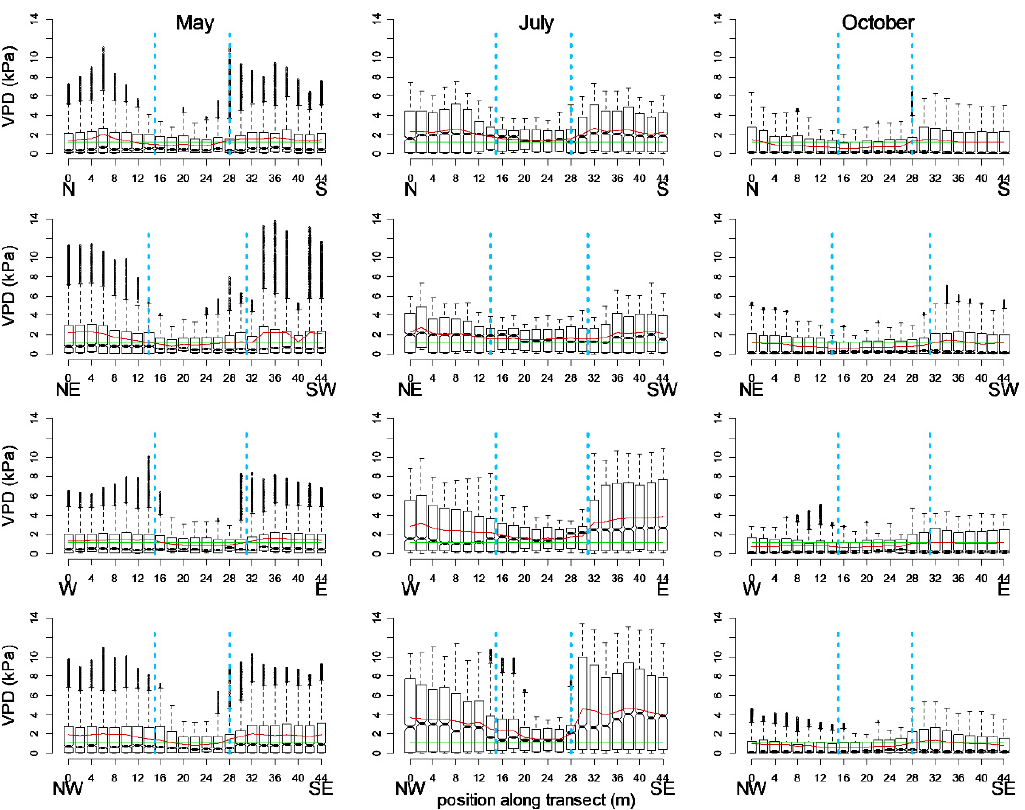
Figure 2. Boxplots of vapour pressure deficit (VPD) values from 24-h periods of three measurement campaigns according to the cardinal directions. Blue dashed vertical lines: visual tree edges; green horizontal lines: VPD threshold (1.2 kPa); red lines: local averages.